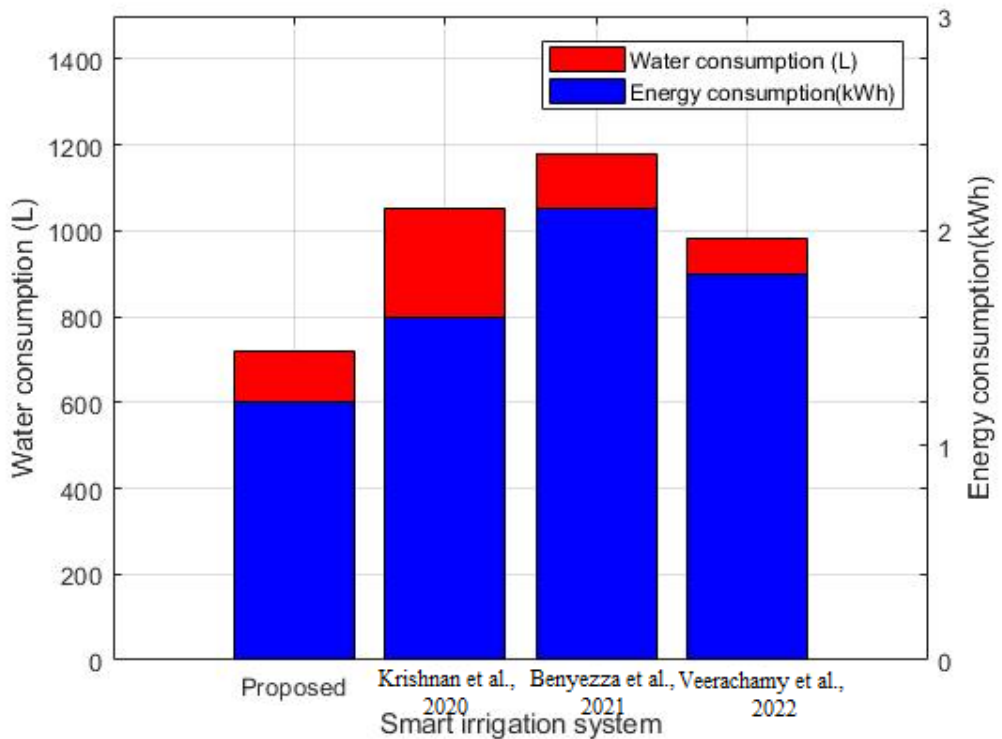
Figure 17. Proposed smart irrigation system and existing systems, such as [65–67], estimated water and energy consumption for the duration of four months.